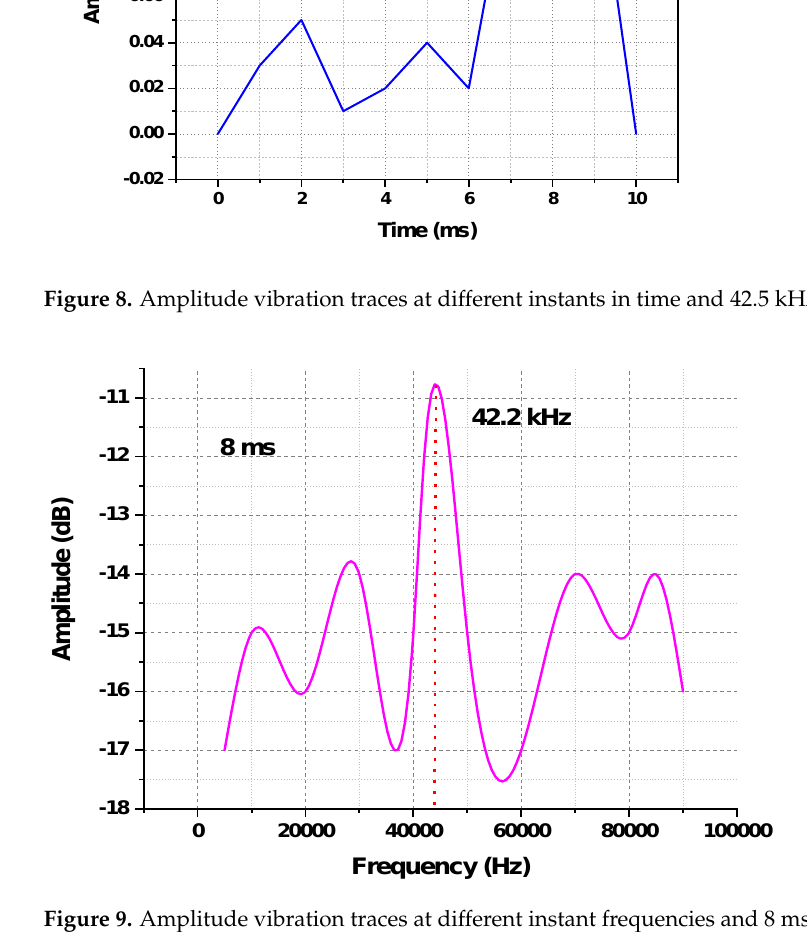
Figure 9. Amplitude vibration traces at different instant frequencies and 8 ms